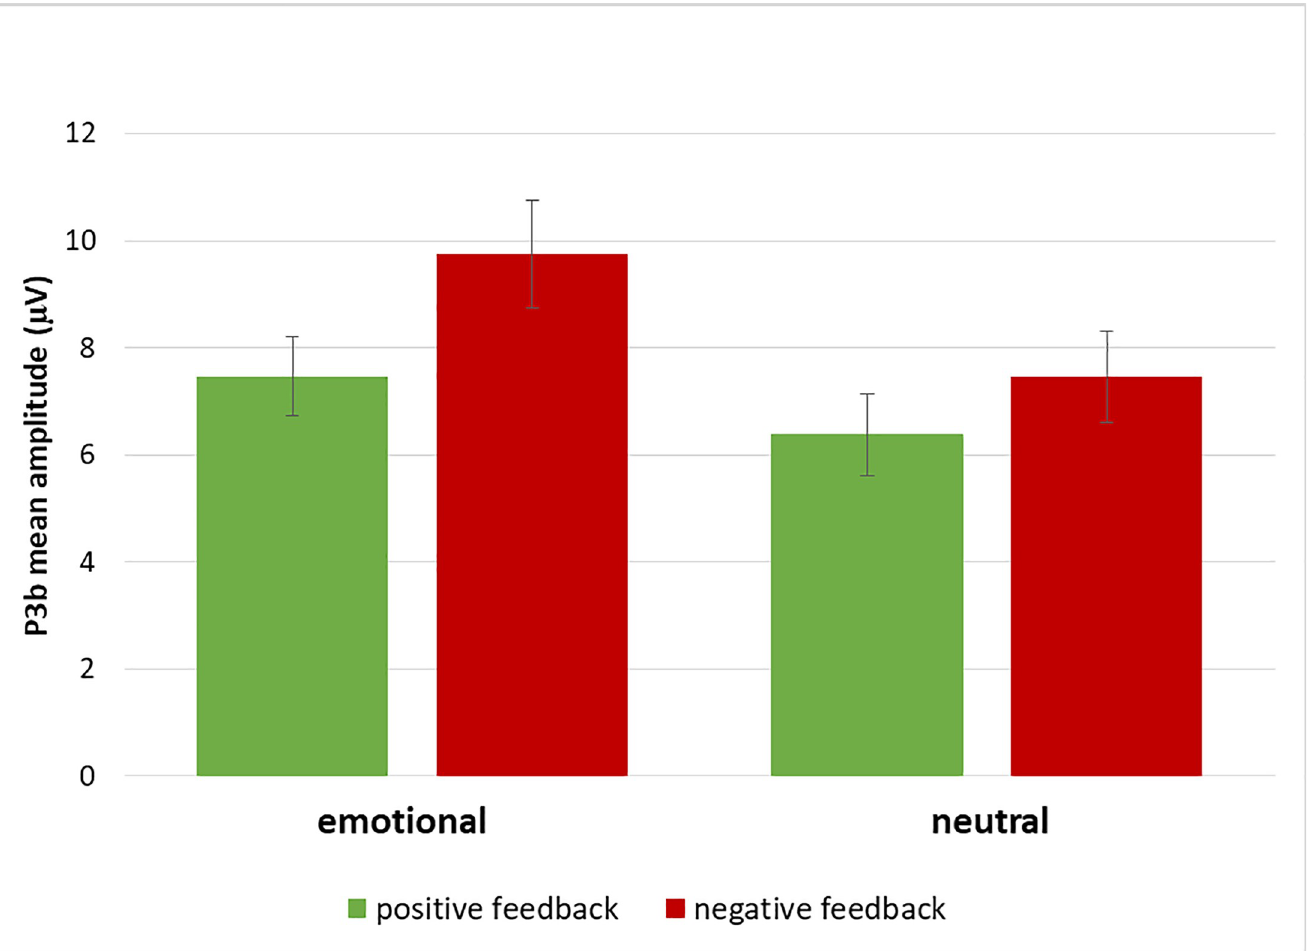
Fig 5. Illustration of the main effects of feedback condition and feedback valence in older adults’ P3b mean amplitudes (whiskers denote standard errors of the mean).